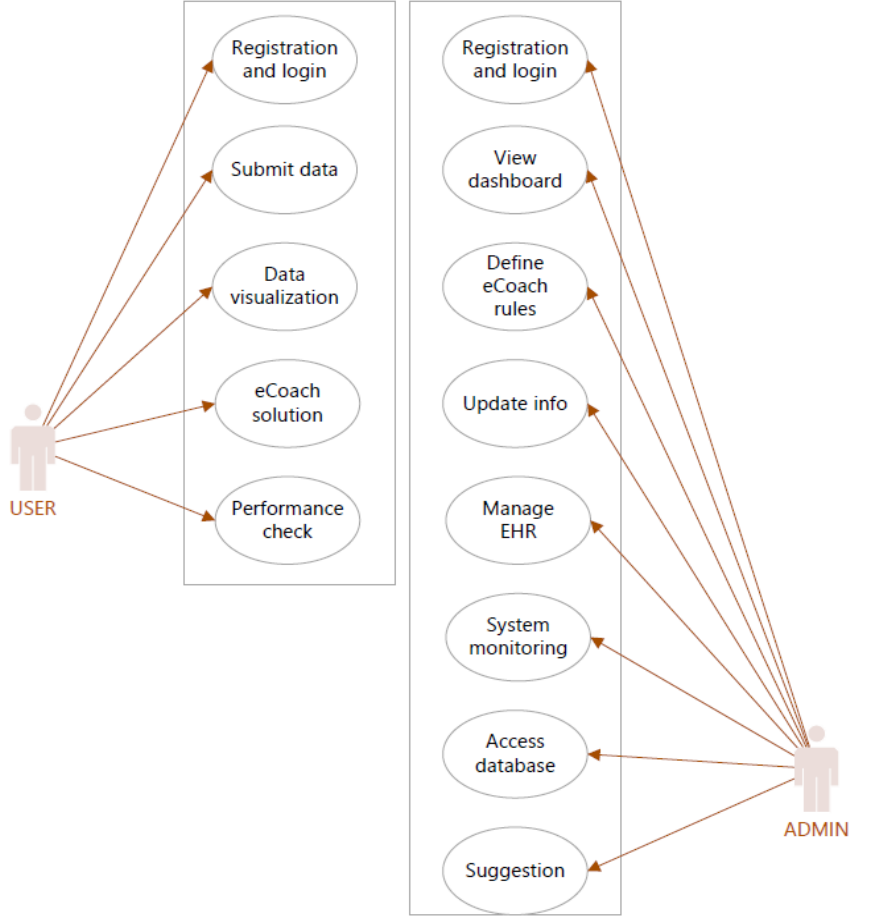
Figure 5. Resource Server (RS) use-case for eCoach prototype system.